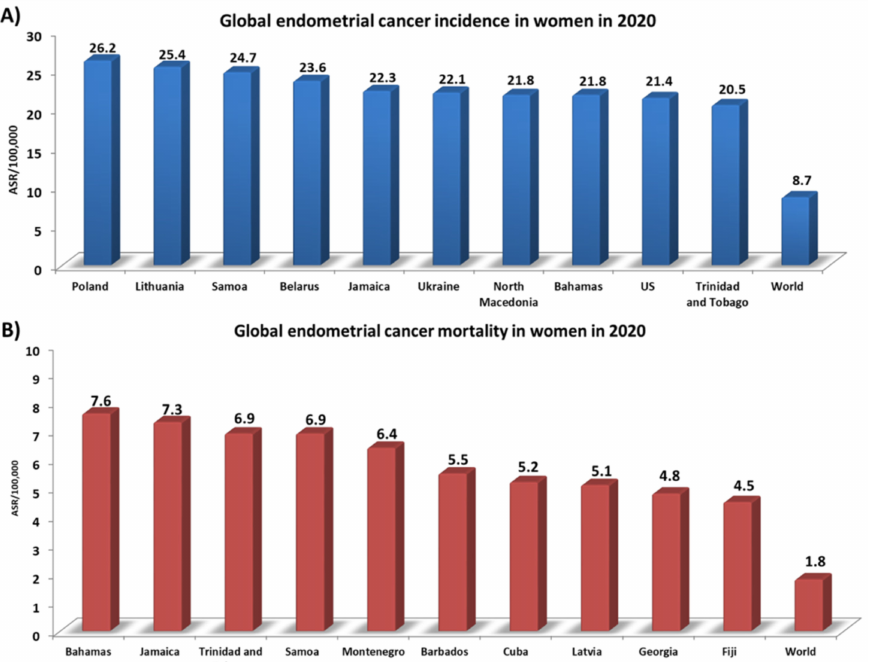
Figure 1. Statistics on the incidence and number of deaths from endometrial cancer in 2020. ( A ) Global endometrial cancer incidence in women in 2020; ( B ) Global endometrial cancer mortality in women in 2020. Abbreviations: ASR: age-standardized rate (based on